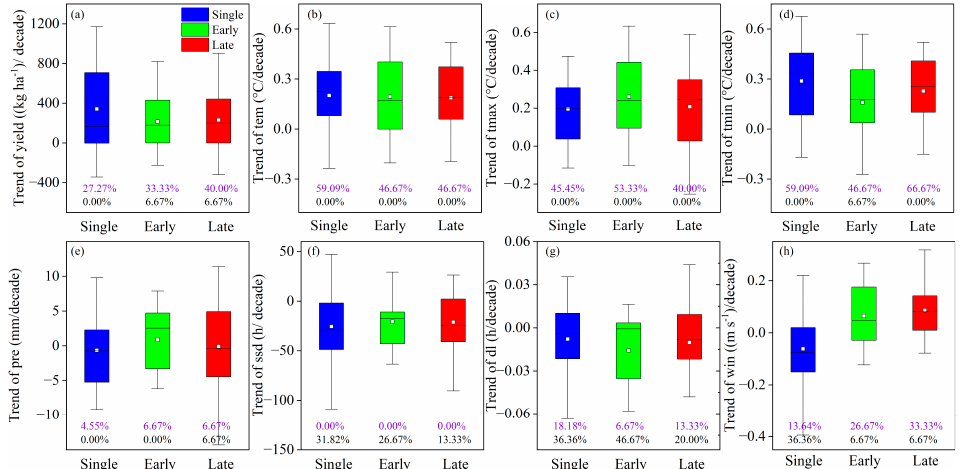
Figure 2. Trends of yield ( a ) and climatic factors ( b – h ) in rice-growing season from 1981 to 2018. Purple fonts indicate the percentage of sites that have significantly increased, and black fonts indicate the percentage of sites that have significantly decreased. ( b – h ) The trend of mean temperature, maximum temperature, minimum temperature, precipitation, sunshine duration, photoperiod, and wind speed, respectively. Table 1. Mutation points of rice yield at each station from 1981 to 2018 based on MK test. Single Sites Mutation